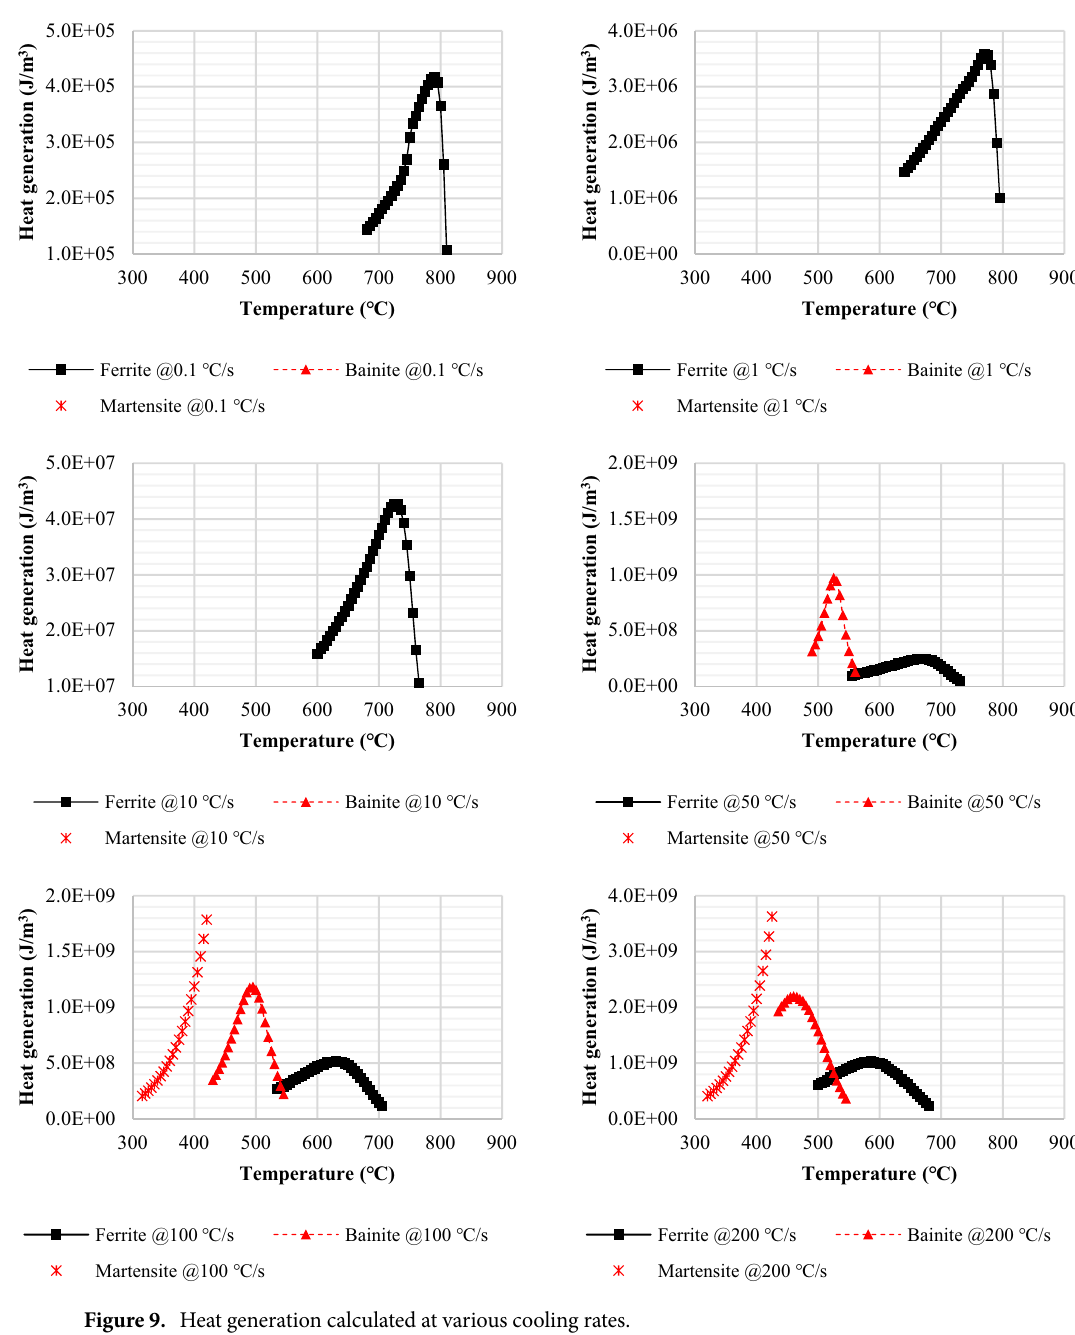
Figure 9. Heat generation calculated at various cooling